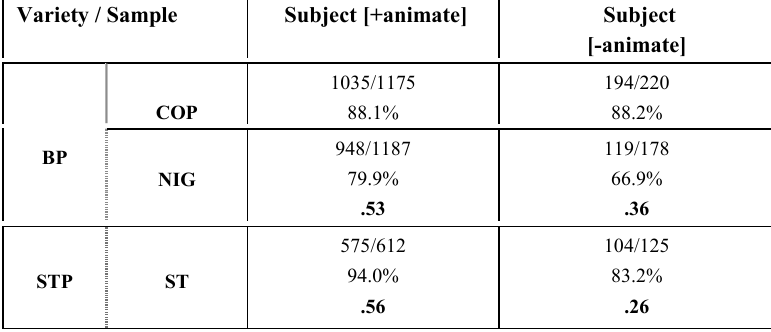
Table XX: Third person plural verbal marking and Semantic feature of the subject by variety of Portuguese Variety / Sample Subject